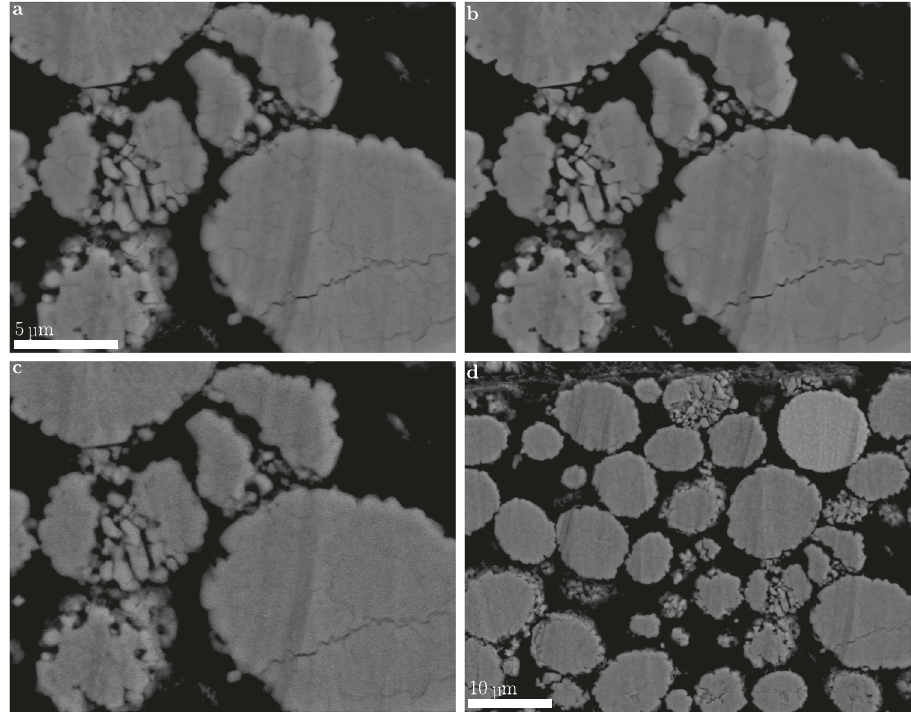
Fig. 6 Training data. Experimentally measured high-resolution image of cracked cathode particles before ( a ) and after denoising ( b ). The corresponding experimentally measured low-resolution image ( c ) was determined via registration from the low-resolution reference image ( d ), where fi gures a – c use the same length